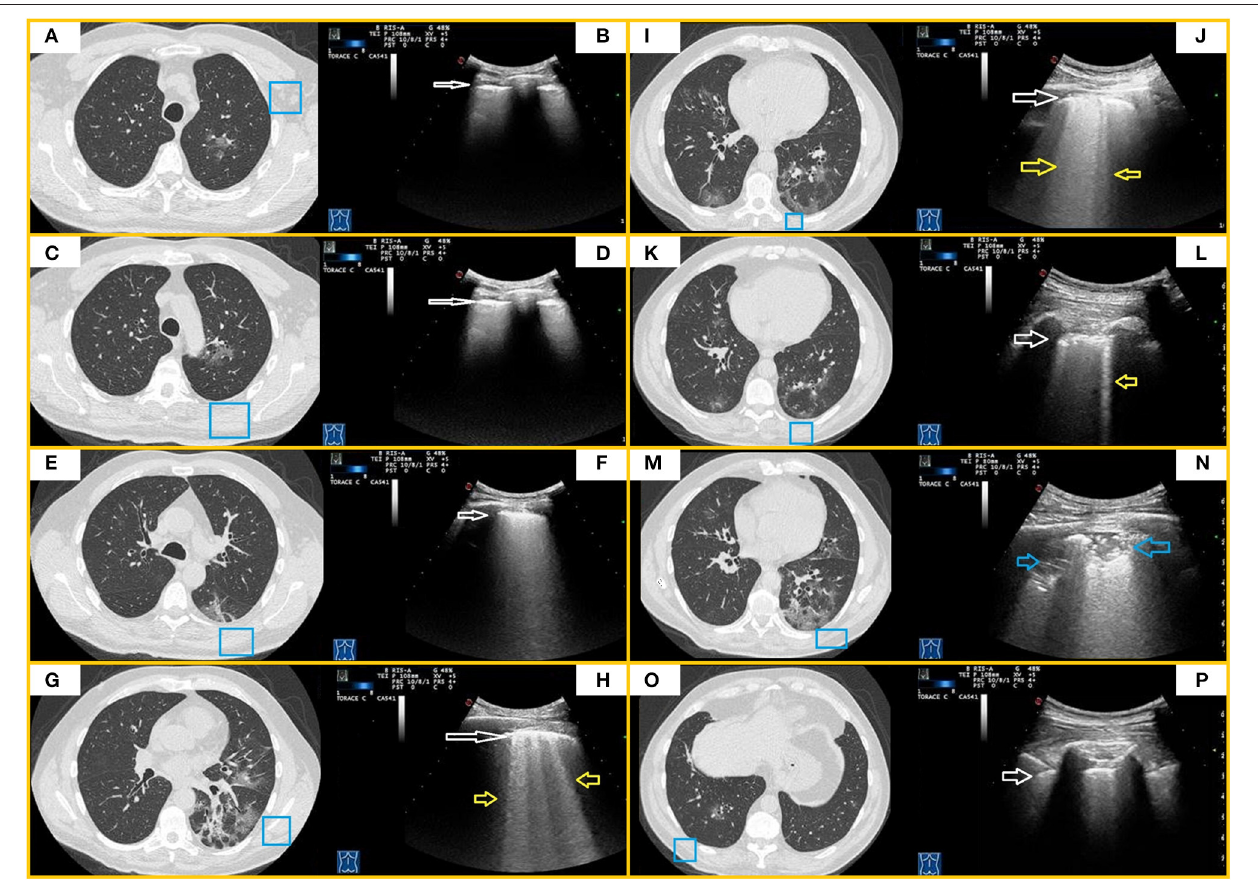
FIGURE 4 | CT and TUS findings in moderate COVID-19 pneumonia. A 67-year-old male patient presenting in ED with fever and cough for 10 days. The RT-PCR assay on nasopharyngeal swab confirmed the suspect for COVID-19 pneumonia. In (A,C) , axial CT scans passing through the upper lobes show central areas of pure ground glass in the left upper lobe. In (E) , axial CT scan passing through the carina level shows a peripheral area of pure ground glass in the left superior lower lobe. In (B,D,F) , ultrasound scans with a convex probe (6 MHz) and thoracic setting, corresponding to the blue boxes on the respective CT scans, show a thickened hyperechoic pleural line without B-lines (white arrow). In (G,I,K) , axial CT scans passing through middle-lower zones show multiple confluent areas of ground glass opacities, with peri-bronchovascular and subpleural distribution, in the lingula and right and left lower lobes. Associated linear opacities with peri-lobular pattern and bronchiectasis are observable in left lower lobes. Initial bronchiectasis is visible in the middle lobe. In (H,J,L) , ultrasound scans with a convex probe (6 MHz) and thoracic setting, corresponding to the blue boxes in the respective CT scans, show an irregular and thickened hyperechoic pleural line (white arrow) with focal or coalescent B-lines (yellow arrows). In (M) , axial CT scan passing through the basal lung regions shows multiple subpleural patchy areas of pure ground glass opacities adherent to pleural surface in the posterior region of the left lower lobe. In (N) , ultrasound scan with a convex probe (6 MHz) and thoracic setting, corresponding to the blue box in the respective CT scan, shows mixed hypoechoic subpleural irregular consolidation (blue arrow). In (O) , axial CT scan passing through the basal lung regions shows some pure ground glass opacities, the largest of which is localized in the right lower lobe along the bronchovascular structures. In (P) , ultrasound scan with a convex probe (6 MHz) and thoracic setting, corresponding to the blue box in the respective CT scans, shows a thickened hyperechoic pleural line (white arrow) without